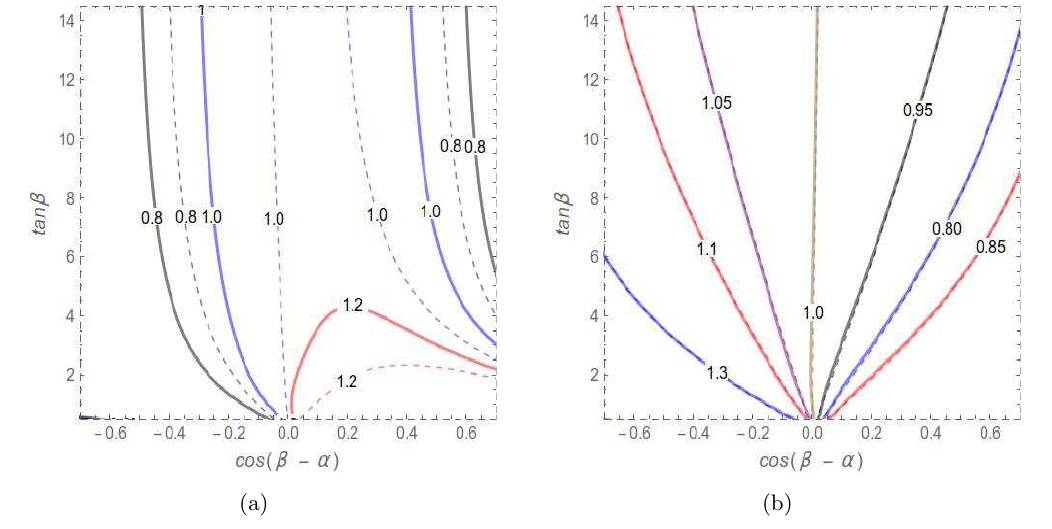
h ) /σ ( gg h ) SM in the 2HDM at → → V V ) /Br ( h V V ) SM in → →